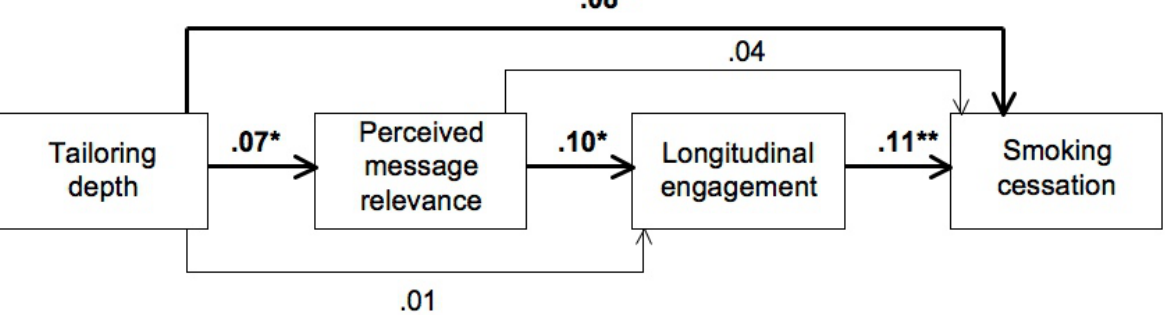
Figure 1. Path analysis of tailoring depth, perceived message relevance, longitudinal engagement, and smoking cessation. Numbers indicate standardized beta coefficients. Participants assigned to the weekly exposure condition (Complete Respondent analysis, n=725; *P < .05;**P <